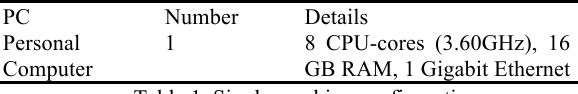
Figure 1 The architecture of the proposed framework